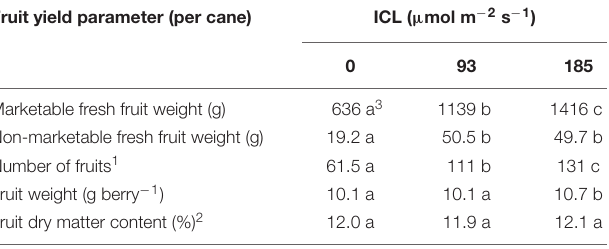
TABLE 4 | Photosynthesis light-response curve (Eq. 1) parameters for blackberry leaves grown at 0 or 185 µ mol m − 2 s − 1 LED ICL: quantum yield ( ϕ ; µ